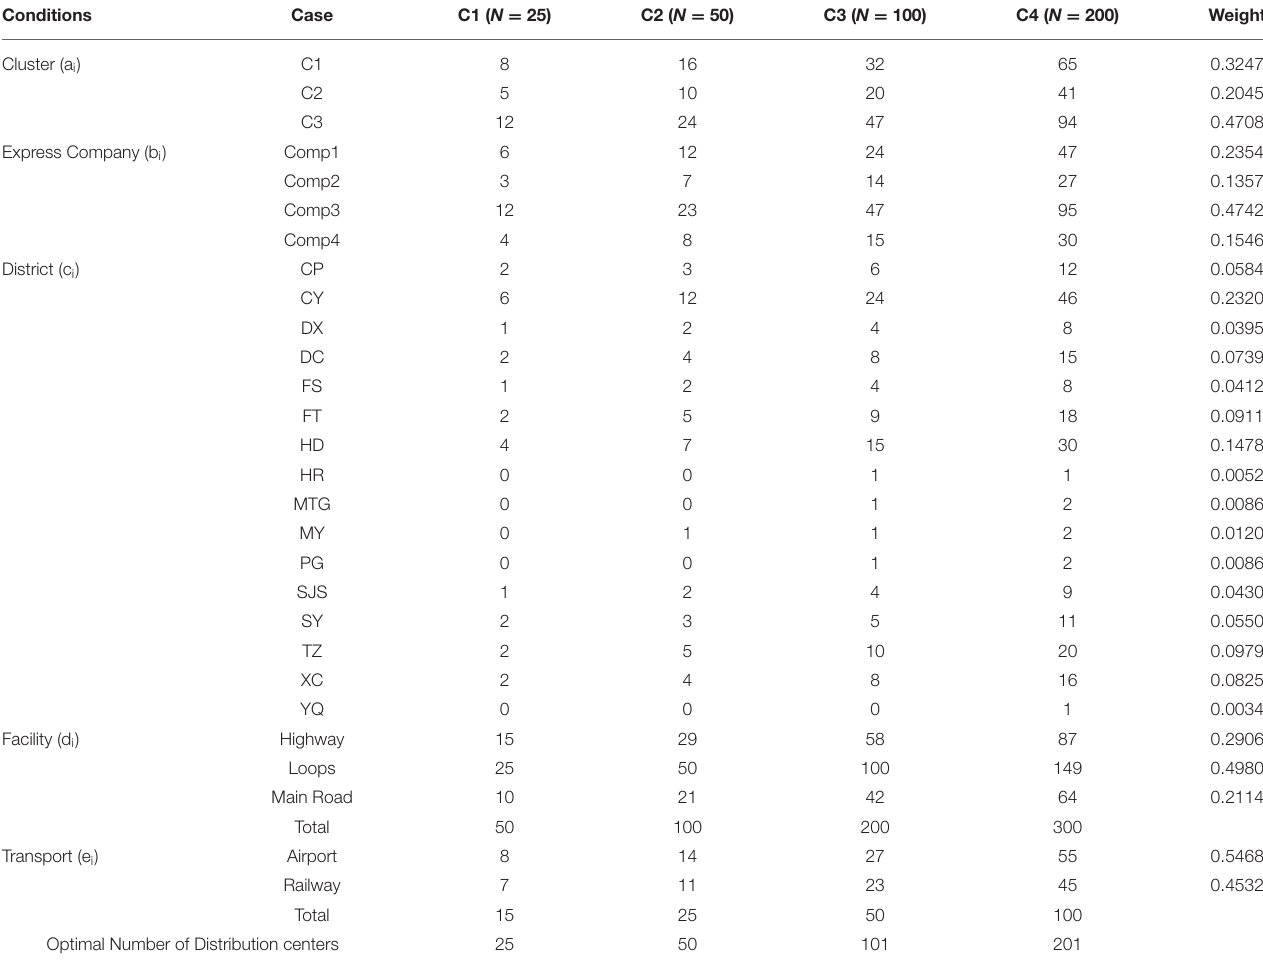
TABLE 2 | Conditions for 0–1 Programming of Distribution centers for Cross-border E-business in Beijing.